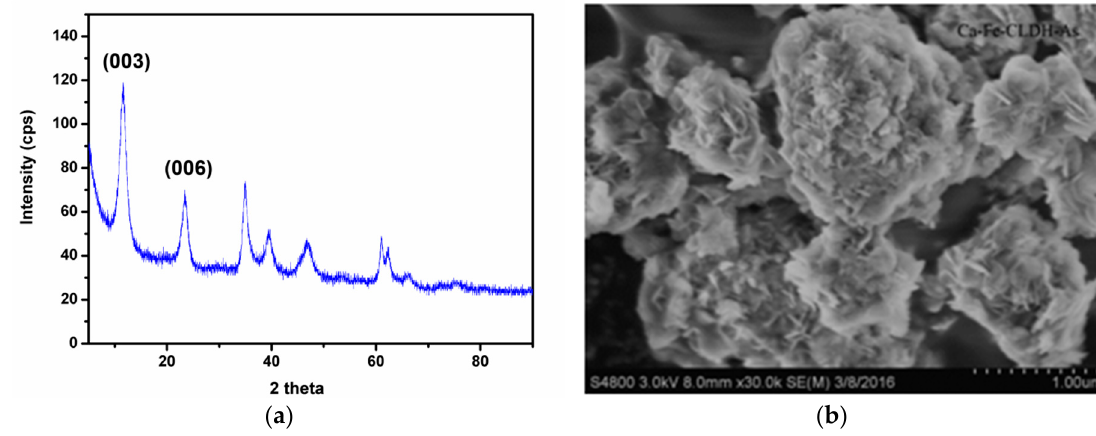
Figure 7. ( a ) XRD pattern of CaFe-CLDH after adsorption of arsenate. ( b ) SEM image pattern of CaFe-CLDH after adsorption arsenate.